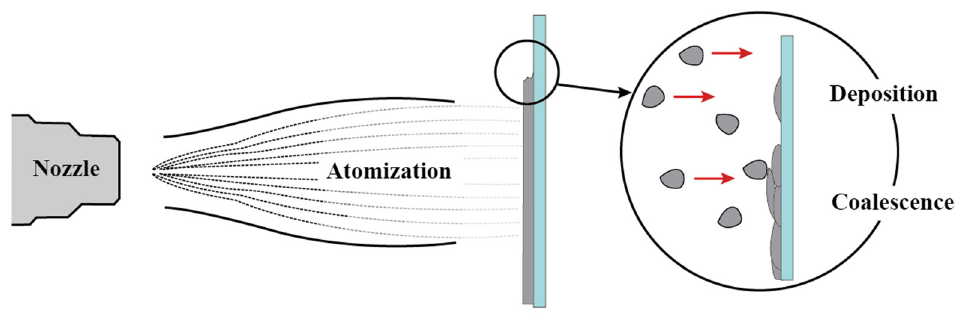
Figure 1. Three steps of the spray